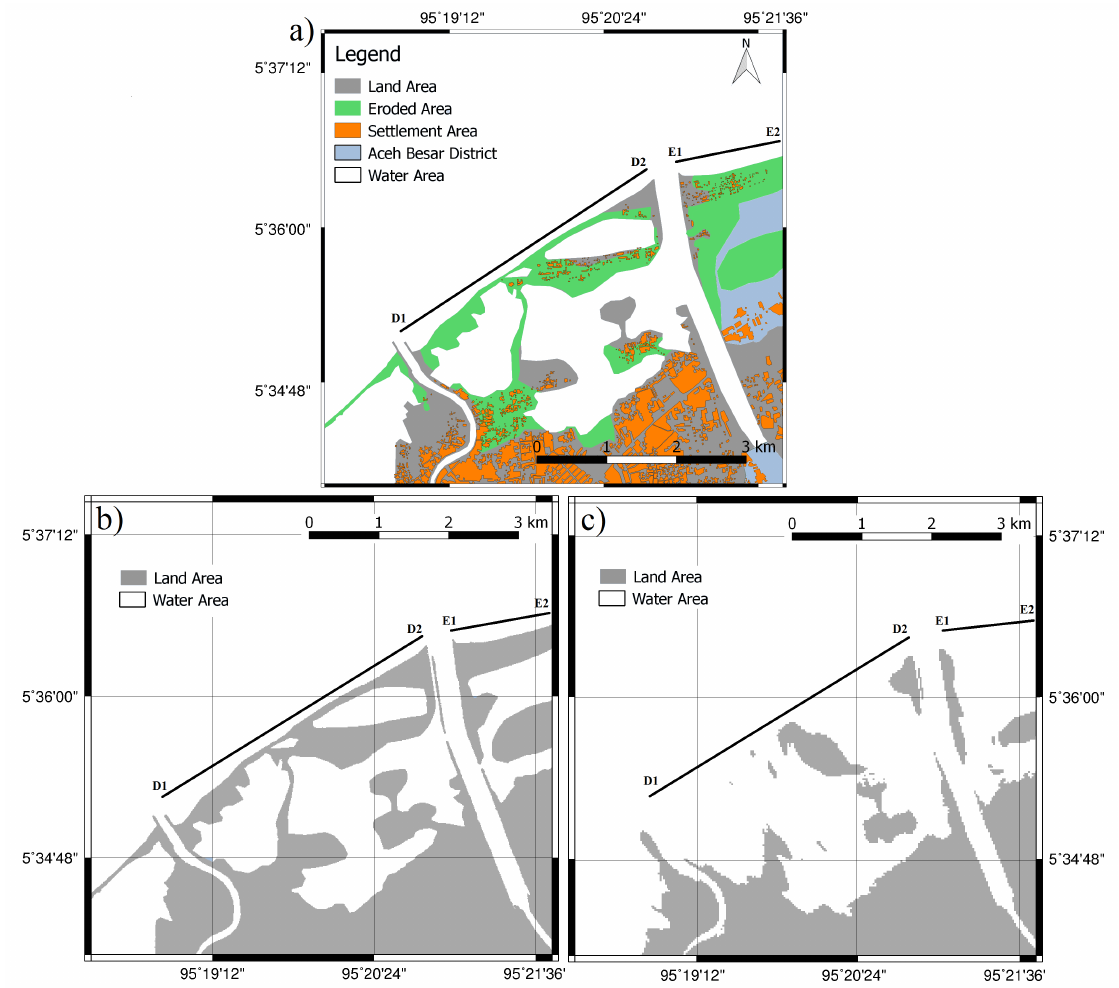
Figure 11. Coastal area comparison between the geospatial data and numerical simulation. ( a ) Green and a gray areas indicate the land condition before the tsunami in 2004. The green area indicates the eroded area after the tsunami in 2004. This figure was modified from [23]. ( b ) before simulated and ( c ) after simulated by